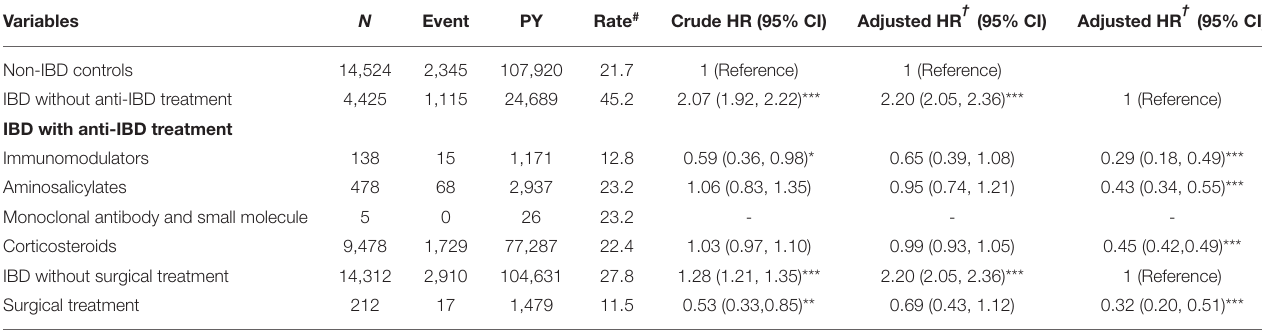
TABLE 4 | Incidence, crude, and adjusted hazard ratio (aHR) of hyperlipidemia compared among inflammatory bowel disease (IBD) patients with and without IBD treatment compared to non-IBD controls. Variables